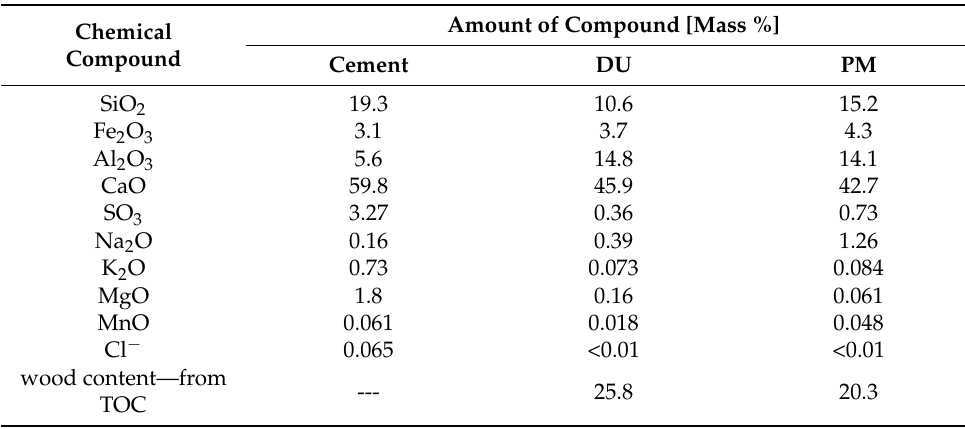
Figure 1. Analysis results of size and distribution of particles in the CEM II/A-S 42,5 R cement. Table 2. Chemical composition of cement and alternative raw materials